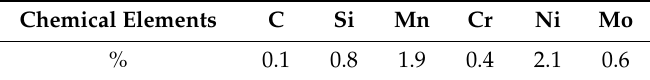
Table 2. Chemical composition of OK AristorodTM 79 (ESAB) wire.